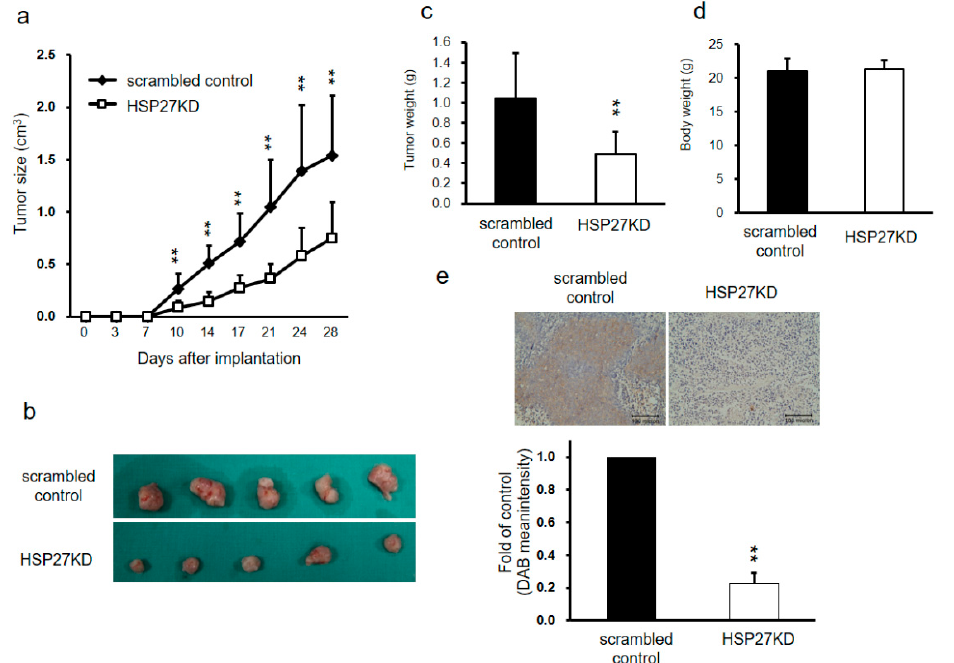
Figure 4. Silenced HSP27 reduced the tumor formation in a xenograft model. ( a ) Scrambled control and HSP27KD DLD-1 cells were implanted subcutaneously into 5-week-old male nude mice. The tumor size was measured twice per week. The plot indicates the tumor volume vs time. Mice were sacrificed on day 28. ( b ) The scrambled control group had larger tumors than the HSP27KD group. ( c ) Tumor weights were plotted and showed that HSP27KD has lower tumor weights than those of the control group. ( d ) The body weight was measured twice per week. At day 28, the body weights of scrambled control and HSP27KD mice were measured and plotted. Similar body weights between the scrambled control and HSP27KD groups. ( e ) HSP27 expression was lower in HSP27KD mouse tumors than in control tumors. There were 5 mice in each group. ** indicates p < 0.005.